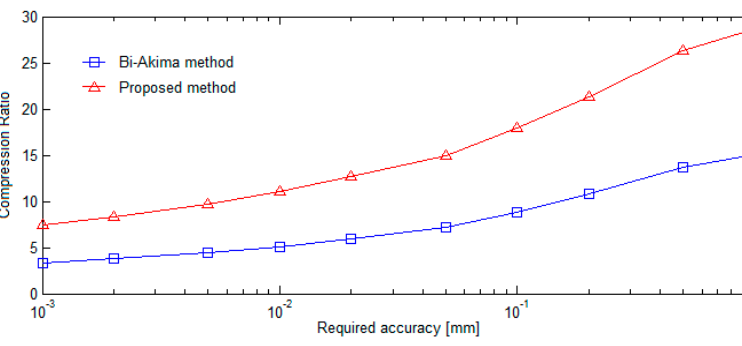
Figure 12. Data compression ratios under different required accuracies.